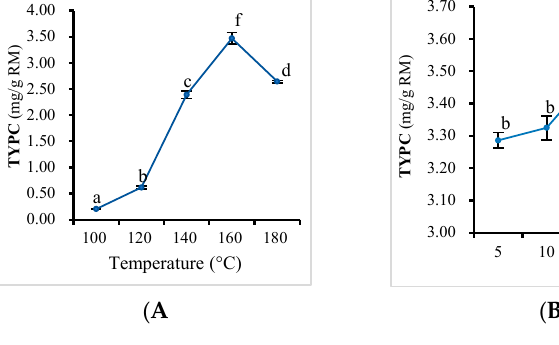
Figure 2. Effect plots of the temperature ( A ), extraction time ( B ), and material-to-liquid ratio ( C ) on the total yield of all identified 19 target phenolic compounds (TYPC) (mean ± SD; n = 3). Values represented with different lowercase letters are statistically significant differences ( p < 0.05).